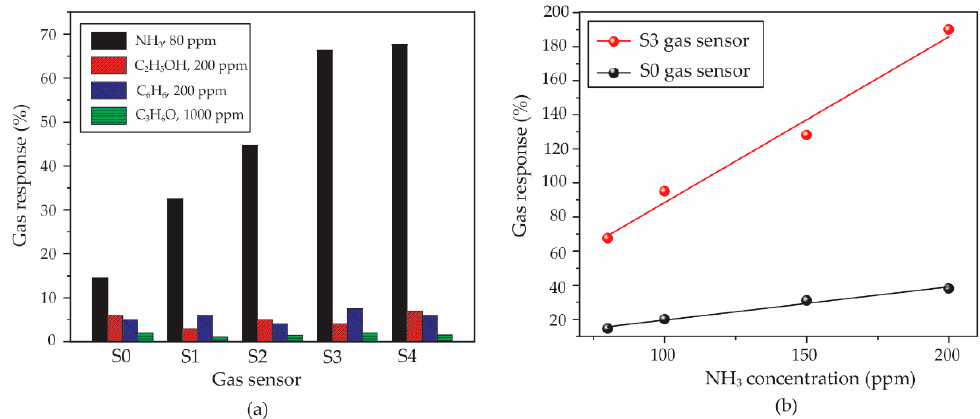
Figure 10. ( a ) Comparison of gas response for all sensors under different test gases. ( b ) Gas response of S0 and S3 gas sensors as a function of NH 3 concentration.